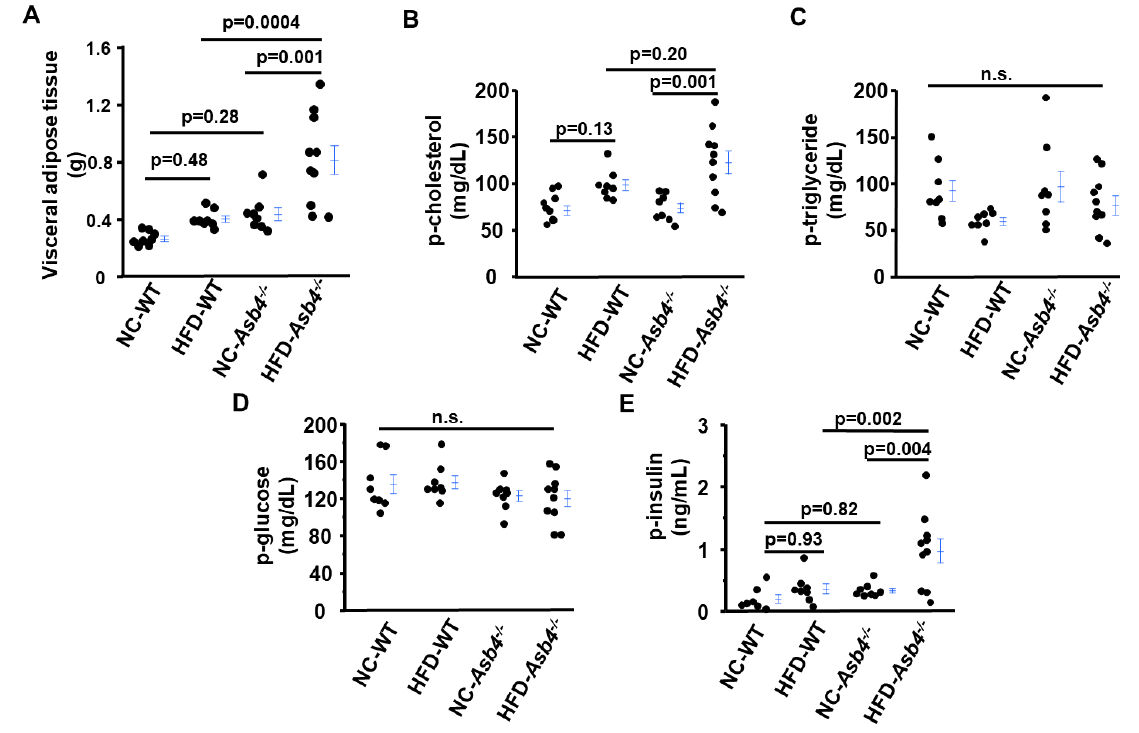
Figure 1. A high-fat diet (HFD) increases the visceral adipose tissue mass and circulating cholesterol and insulin levels in Asb4 −/− dams but not triglyceride and glucose levels. WT and Asb4 −/− pregnant mice were euthanized at 18.5 days post-coitus (dpc) after 4 h fasting, and blood was collected for determining ( A ) visceral adipose tissue mass, ( B ) plasma (p) cholesterol, ( C ) triglyceride, ( D ) glucose, and ( E ) insulin. WT: wild type; NC: normal diet; HFD: high-fat diet; n.s.: not significant. n = 8 (NC-WT), 8 (HFD-WT), 8 (NC- Asb4 −/− ), 10 (HFD- Asb4 −/− ). 2.2. A High-Fat Diet (HFD) Increases Circulating Levels of Cholesterol, Insulin, and Leptin in Asb4 −/− Dams without Changes in Glucose Levels HFD- Asb4 −/− dams had ~1.6× higher plasma cholesterol levels than NC- Asb4 −/− dams.